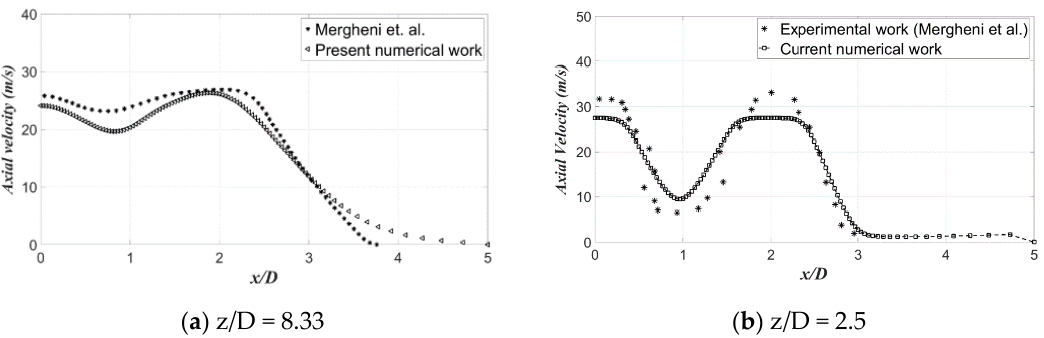
Figure 5. Validation of axial velocity variation in radial direction.